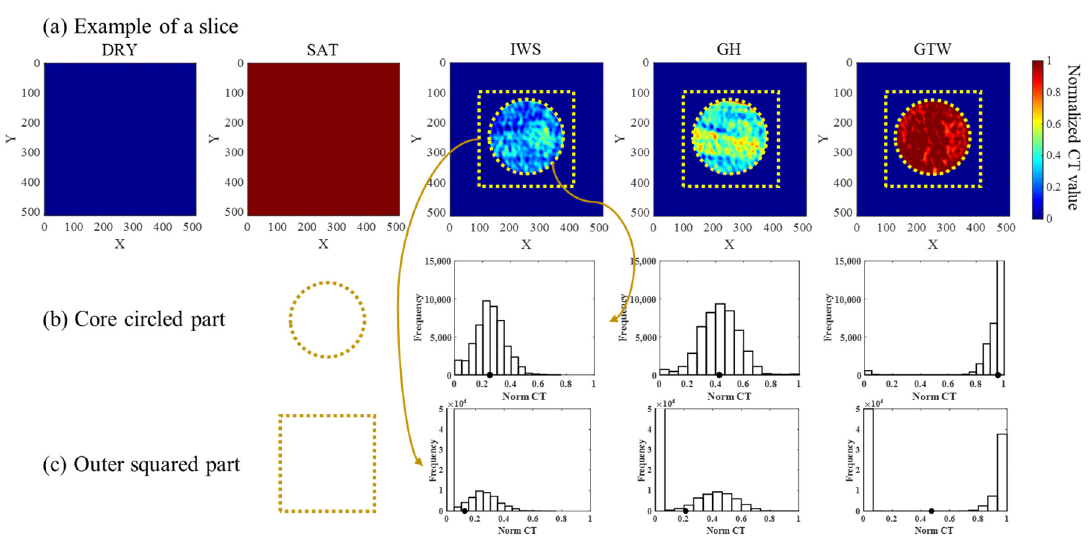
Figure 10. The normalized CT values in the first slice of sample A presented with a color scale. Table 2. Conditions and settings for the training of the RF, CNN, and SVM.